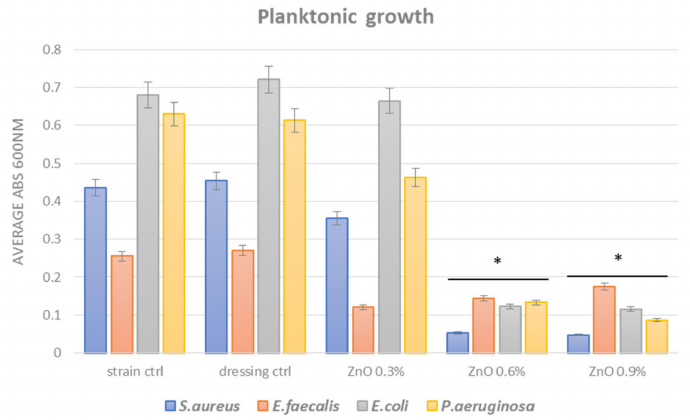
Figure 7. Graphic representation of average absorbances at 600 nm revealing growth of planktonic microbial cultures in the presence of control and nano-coated dressings for 24 h at 37 ◦ C (* p < 0.05 by comparing average Abs 600 nm of all strains of the analyzed species growth in the presence of control and ZnO NPs containing